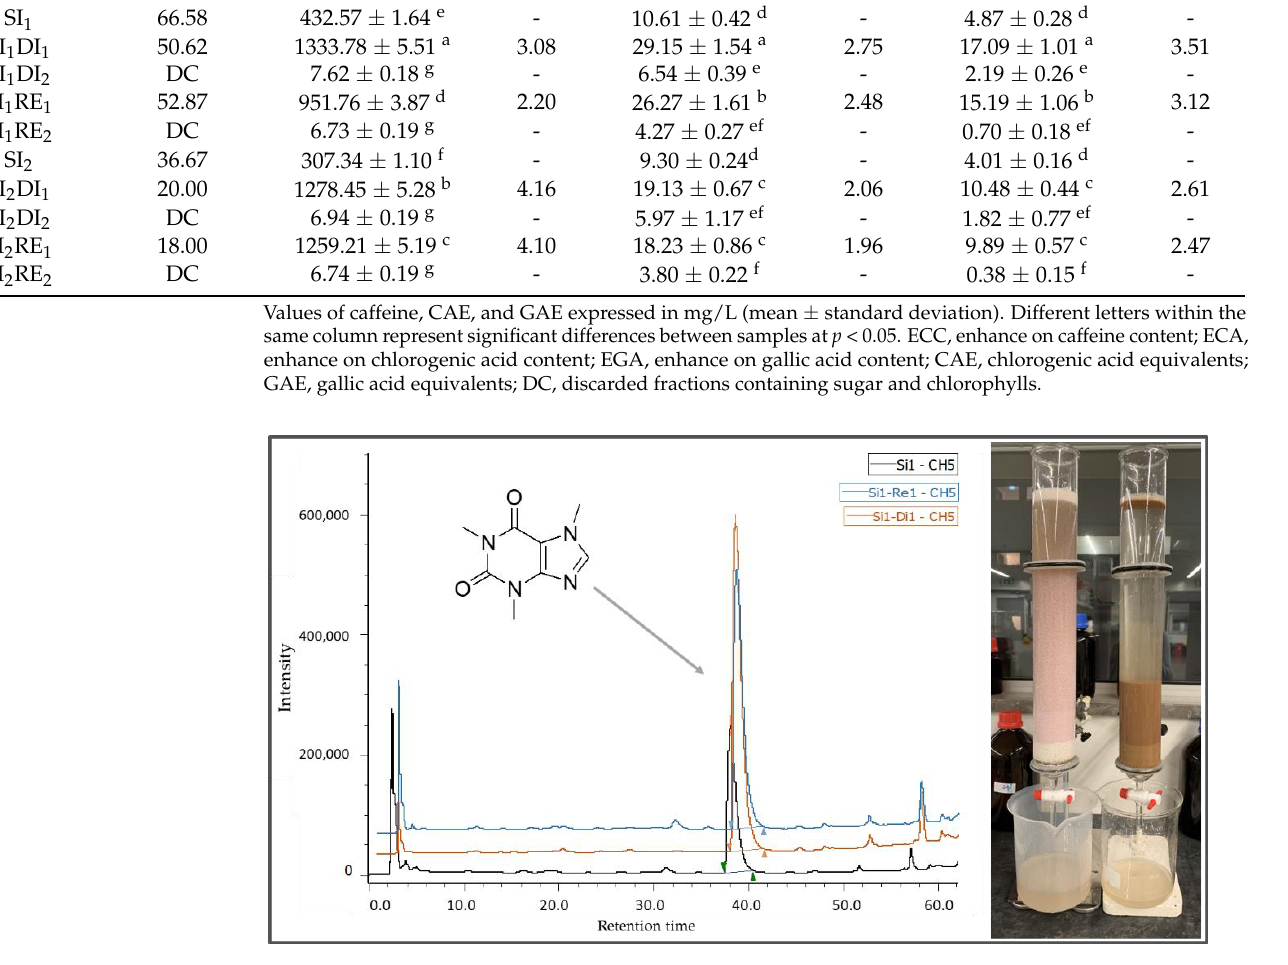
Figure 1. HPLC chromatogram of caffeine before and after enrichment.